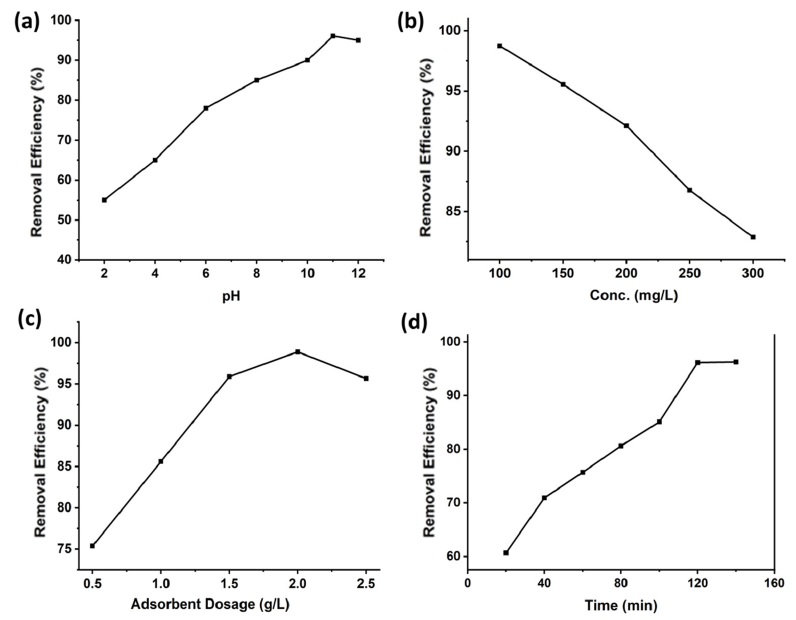
Figure 3. Effect of various factors on MG adsorbed by ZIF-67 ( a ) Effect of initial pH of the solution; ( b ) Effect of initial MG concentration ( c ) Effect of adsorbent dosage ( d ) Effect of contact time.